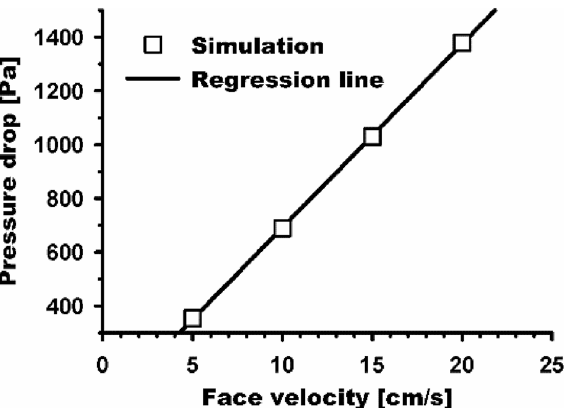
Figure 6. Relationship between face velocity and pressure drop on nanofiber filters. The line represents a fitting curve with a square root value higher than 0.99.